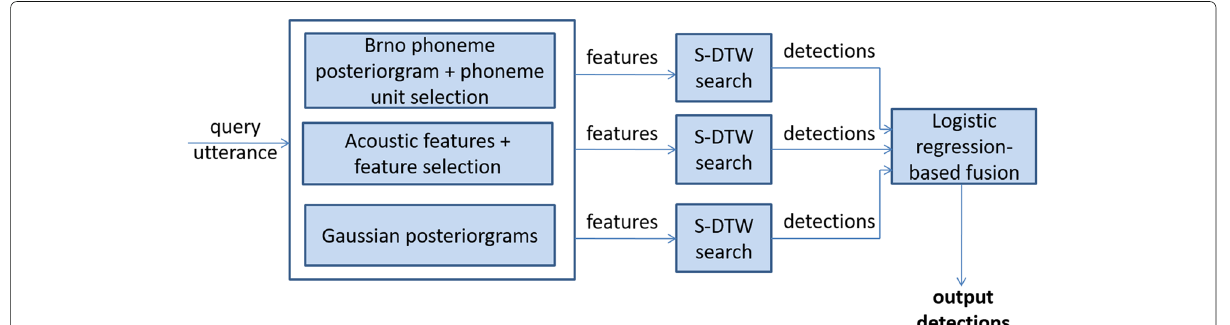
Fig. 1 A-GTM-UVigo-Three feature+DTW-based fusion QbE STD system